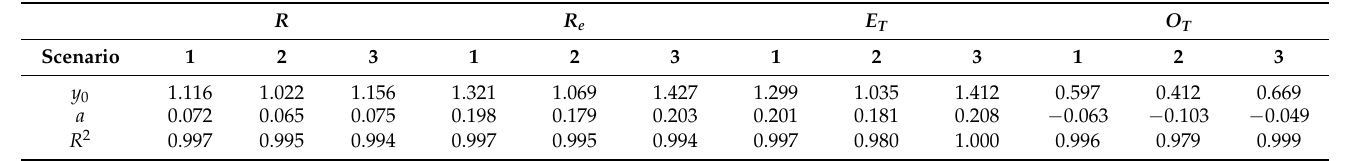
Table 2. Coefficients ( y 0 and a ) and Pearson coefficient ( R 2 ) of the logarithmic regression function for the four reliability indices in each collection